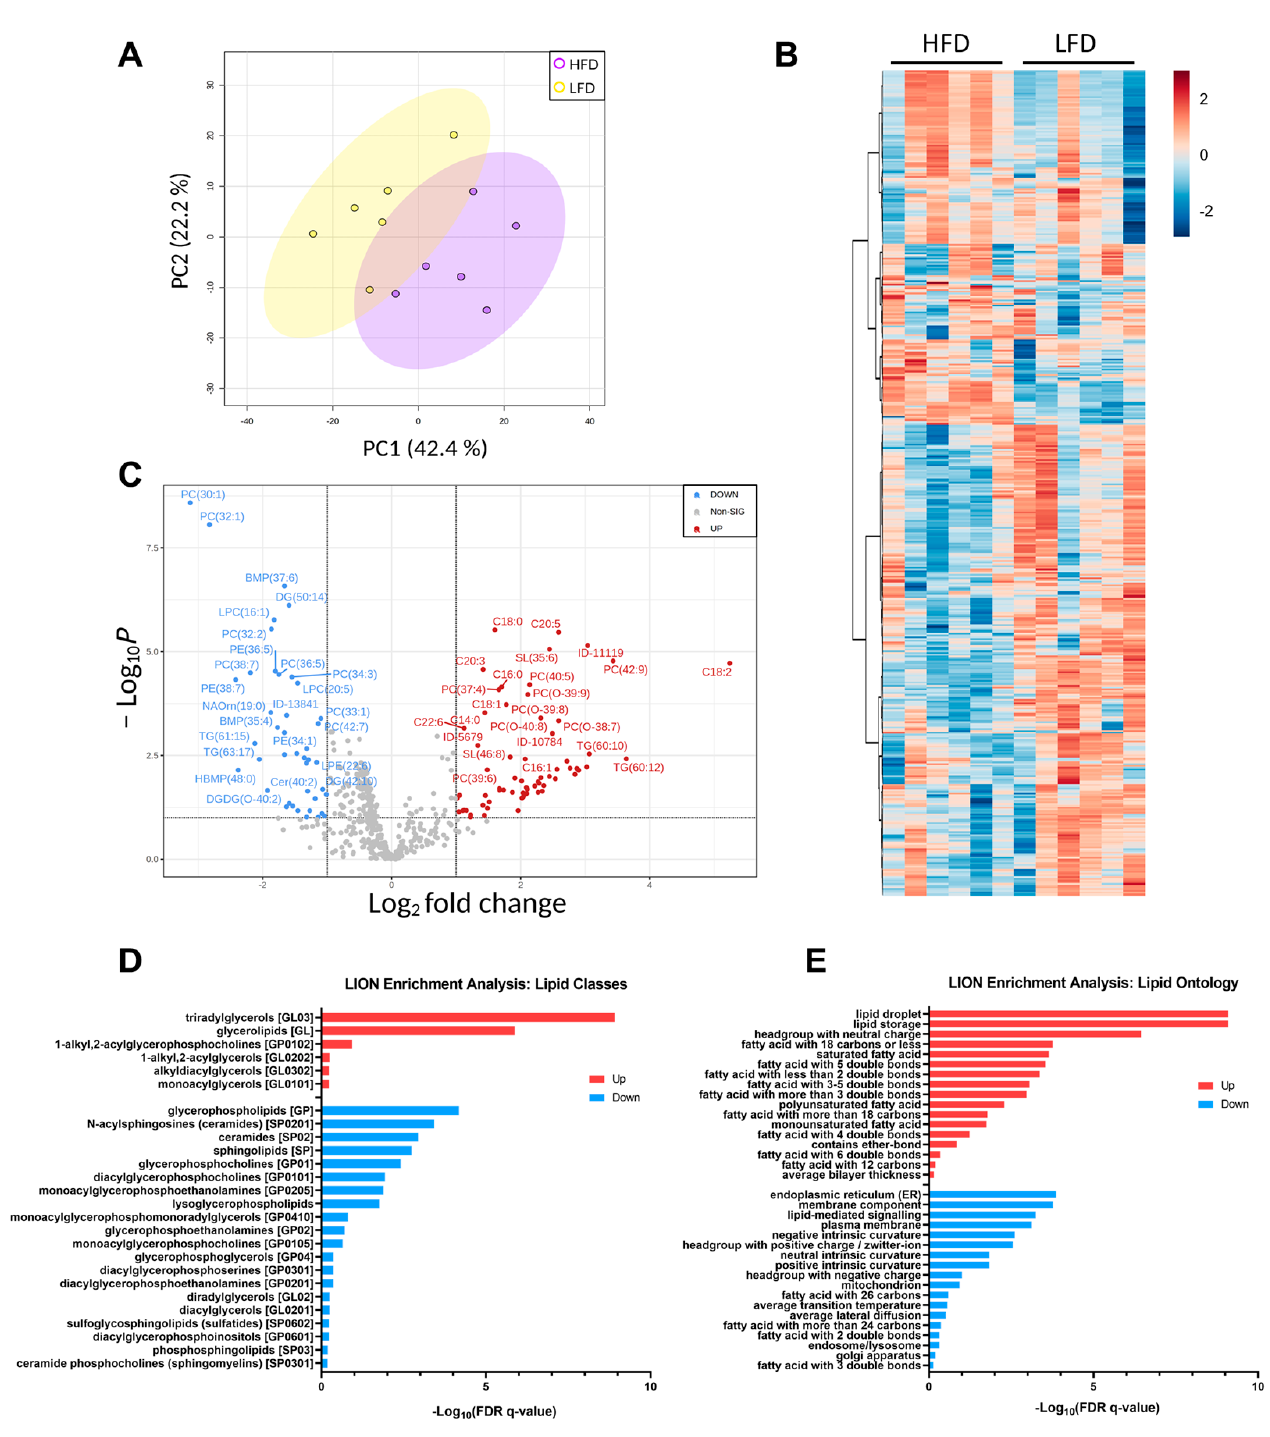
Figure 6. Lipid profiles. ( A ) PCA plot of each biological replicate. ( B ) Heatmap representation of all significantly changing lipids. Red indicated upregulated lipid species, and blue indicated downregulated lipid species. ( C ) Volcano plot of all quantified lipids. ( D ) Principal lipid classes changed in the two groups. ( E ) Lipid ontology enrichment for function, cellular component and chemical and physical properties significantly